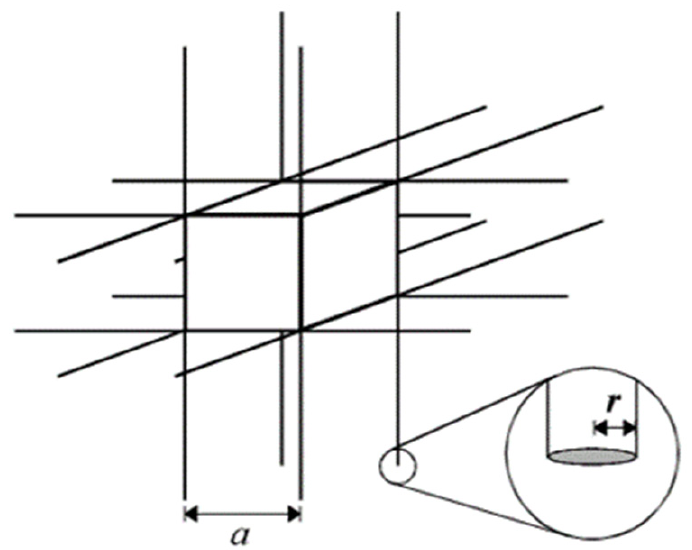
Figure 1. Pendry’s artificial microstructure design for manipulating low-frequency plasmons. Re- printed with permission from [43] (As follows: [J. B. Pendry et al., Physical Review Letters, Volume 76, Pages 4773–4776, 1996.], copyright (1996) by the American Physical Society).